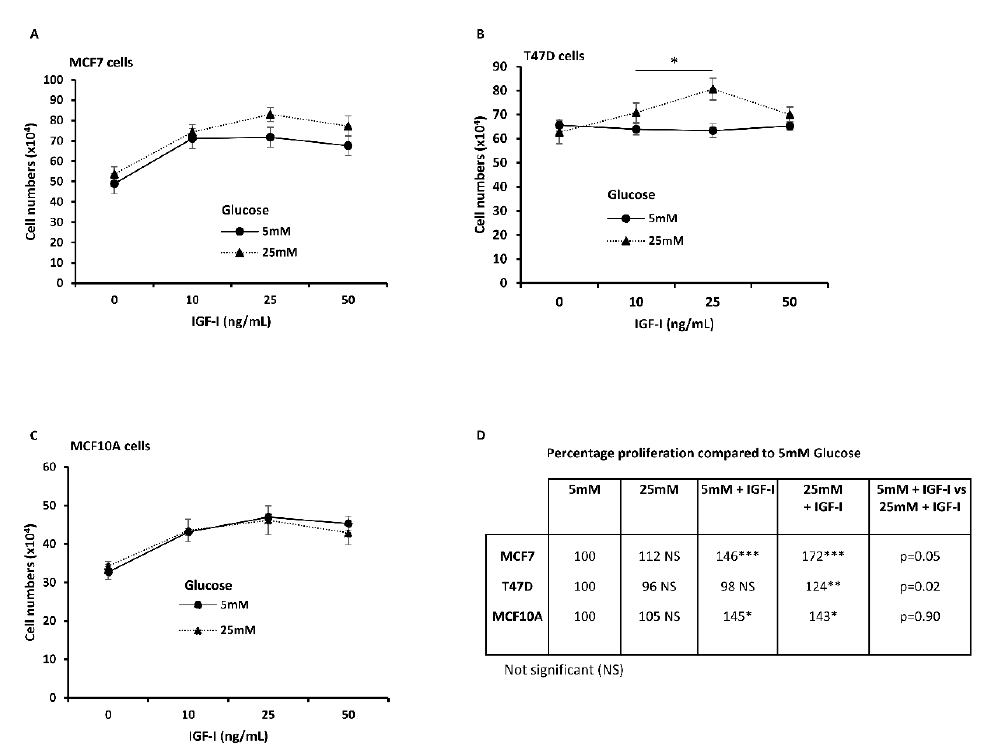
Figure 5. High glucose modulates insulin ‐ like growth factor I (IGF ‐ I) ‐ induced cell growth in breast cancer cells, but not in benign mammary epithelial cells. Breast cancer cell lines; ( A ) MCF7, ( B ) T47D, and normal mammary epithelial cell line ( C ) MCF10A were treated with 0, 10, and 25 ng / mL IGF-I for 48 h under normal and high glucose conditions. Total cell numbers were determined using trypan blue exclusion dye cell counting. The graphs represent mean ± SEM of three independent experiments with each condition performed in triplicate. ( D ) Absolute cell numbers after exposure to normal and high glucose with or without 25 ng / mL, normalised to normal glucose (5 mM) and expressed as a percentage. Three independent experiments were performed, and mean values are presented. One-way ANOVA, followed by Bonferroni’s multiple comparison test was used statistical analyses. * p < 0.05, ** p < 0.01 and *** p < 0.001.